Question: Write a single sentence explaining what this figure depicts.
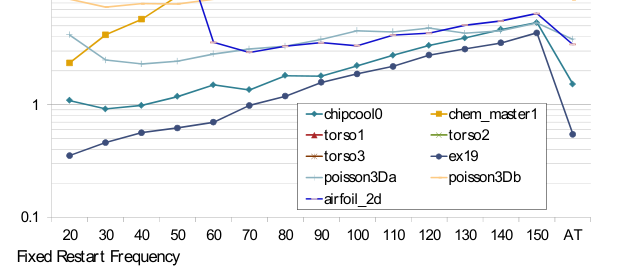
Answer: Auto-tuning Effect of Restart Frequency for  OpenATI_EIGENSOLVE(Arnoldi) on the T2K (16 threads).